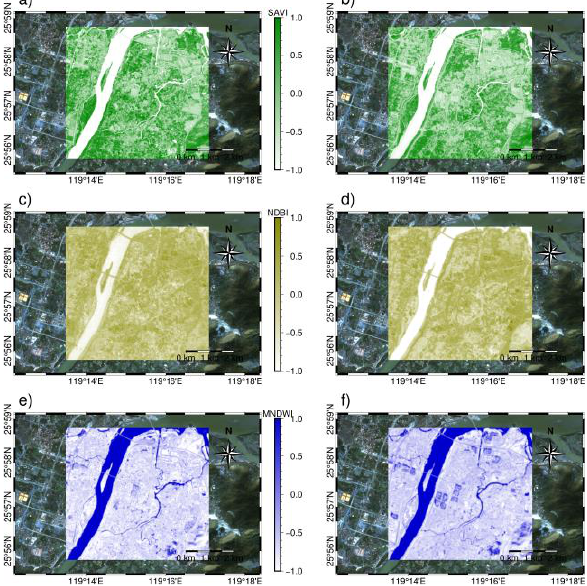
Jan. 2022 Figure 8 . The SAVI, NDBI and MNDWI values of area C at January 2016 and January 2022.